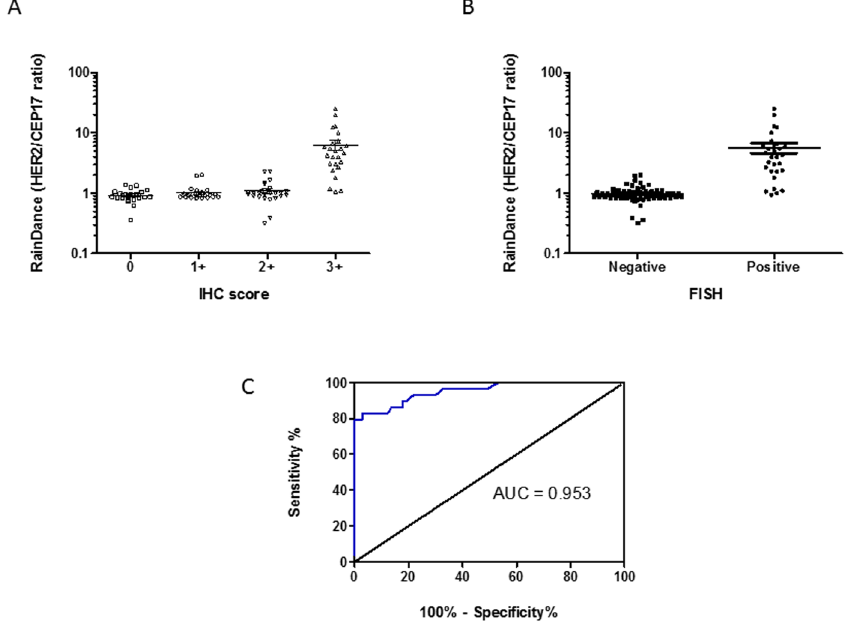
Figure 1. HER2:CEP17 ratio by ddPCR in the development cohort. ( A ) dot plot showing the HER2:CEP17 ratio with different IHC score and ( B ) HER2 − and HER2 + status. ( C ) ROC curve to determine the optimal